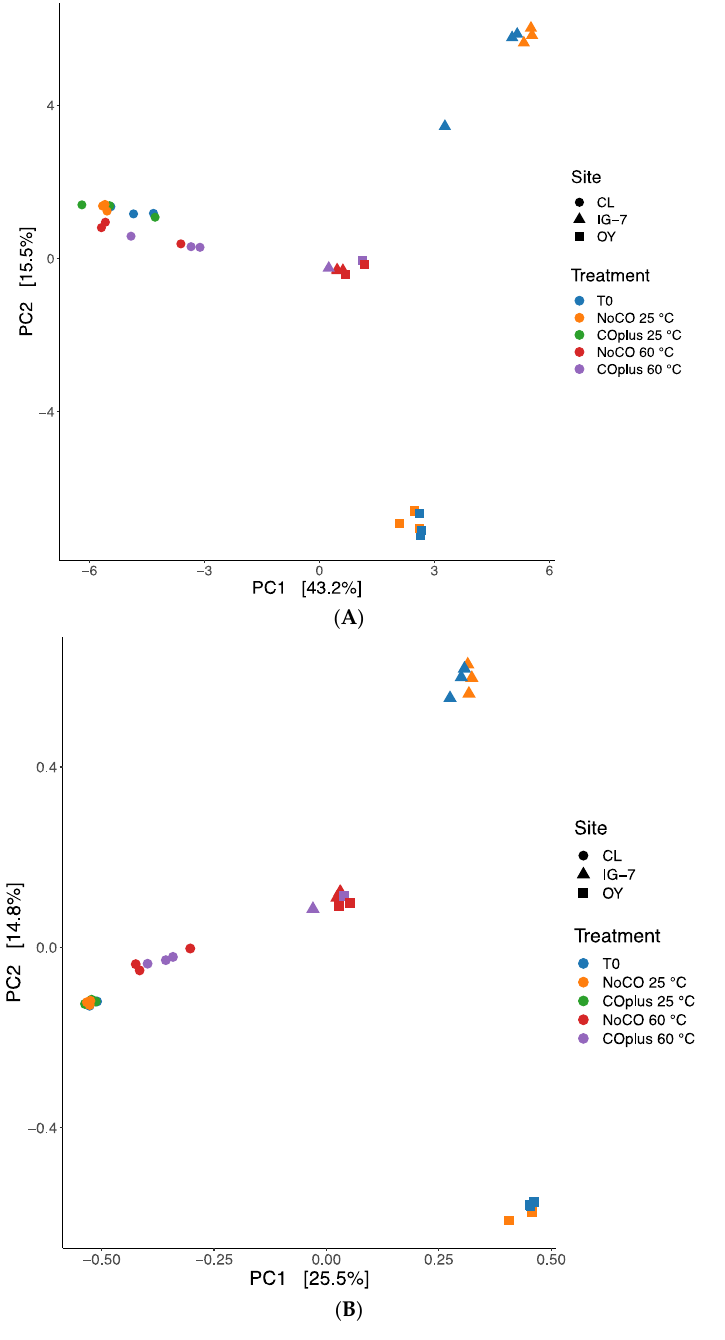
Figure 6. Redundancy analysis for sites CL, IG-7 and OY. Samples are grouped by treatment and site using an Aitchison distance metric (CLR transformed data, A ) or Hellinger distance metric ( B